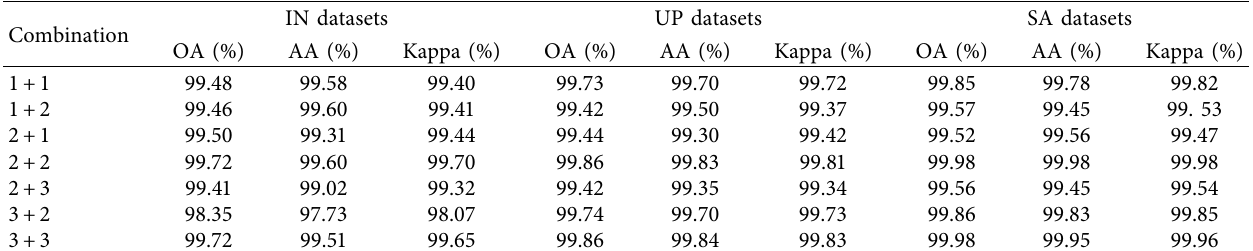
Table 5: Accuracy of different residual block combinations.